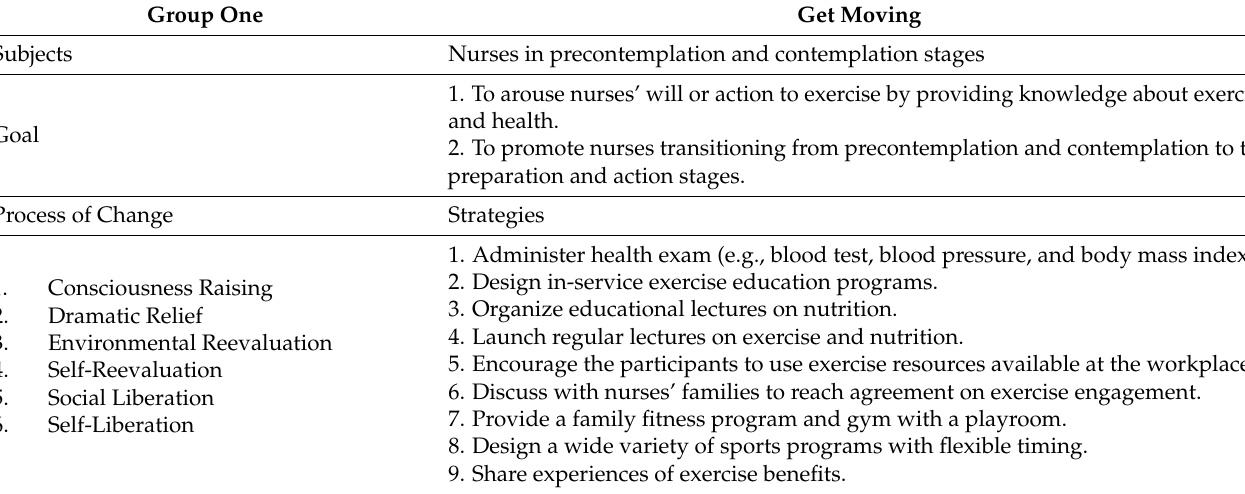
Table 1. Teaching strategies for group one—“Get Moving”.